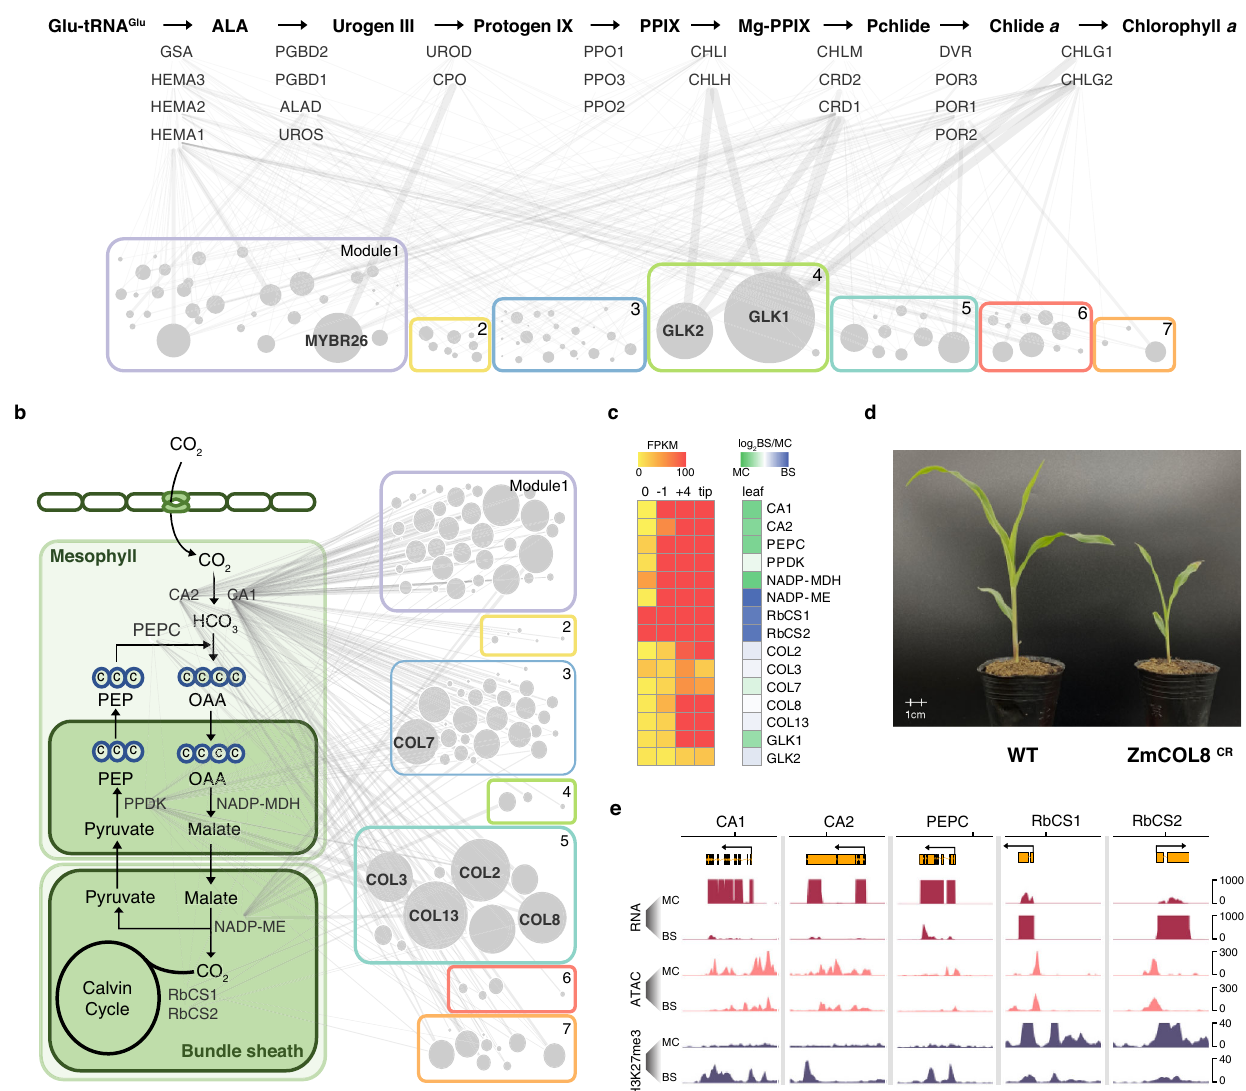
Fig. 5 Identifying key regulators based on local TF connectivity. a The chlorophyll biosynthesis pathway. The genes encoding key enzymes for each step are shown below the arrow. The widths of the edge between TF and gene represent regulatory potential based on the TIP model. The 104 TF nodes are represented as circles and grouped into 7 modules, with size proportional to the sum of the regulatory potential. b The maize photosynthetic carbon pathway. Key genes encoding enzymes responsible for CO 2 fi xation and transport between mesophyll and bundle sheath cells are shown. c Heatmap showing the expression gradient of core C 4 photosynthesis genes in four leaf sections from base to tip, as well as their mesophyll and bundle sheath cell- speci fi c expression patterns. d Pale-green leaf and seedling lethal phenotypes of the COL8 CRISPR/Cas9 mutant. e Cell-type speci fi c H3K27me3 in core C 4 gene loci. MC mesophyll cells, BS bundle sheath cells. Source data underlying Fig. 5c are provided in a Source Data fi